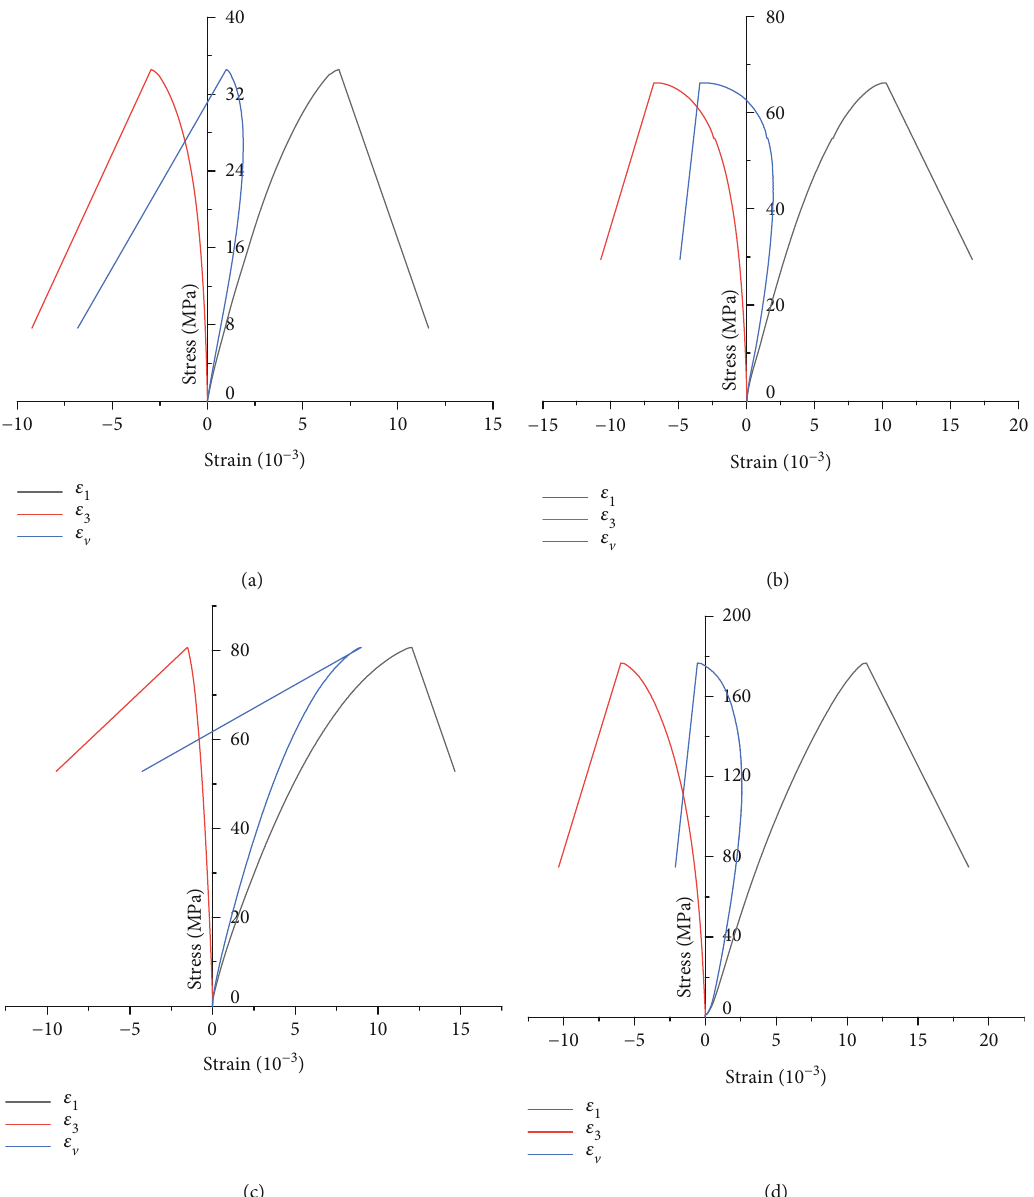
Figure 7: Stress-strain curves of T-M coupled tests results: (a)Stress-strain curve of TM-0-45; (b)Stress-strain curve of TM-5-45; (c)Stress- strain curve of TM-10-45; (d)Stress-strain curve of